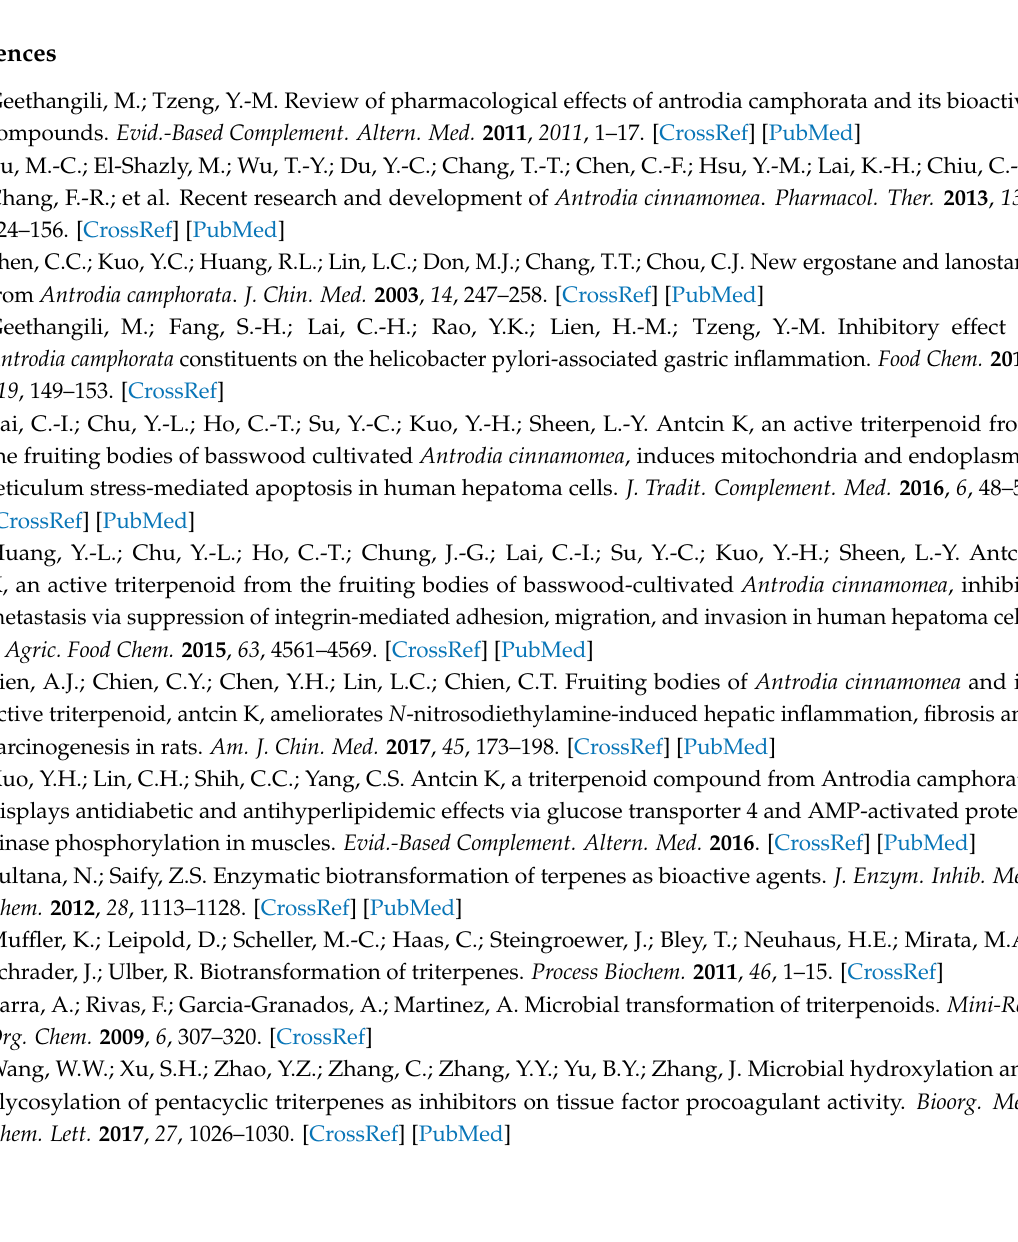
Table S1: NMR spectroscopic data for compound ( 1 ) and compound ( 2 ) (in pyridine- d 5 ; 700 MHz). Figure S1: The UPLC analysis of 24 h fermentation broth of B. subtilis ATCC 6633 in the absence of antcin K. Figure S2: The 1 H-NMR (700 MHz, Pyridine- d 13 C-NMR (176 MHz, Pyridine- d 5 ) spectrum of compound ( 1 ). Figure S3: The 5 ) spectrum of compound ( 1 ). Figure S4: The DEPT-90 and DEPT-135 (176 MHz, Pyridine- d 5 ) spectra of compound ( 1 ). Figure S5: The HSQC (700 MHz, Pyridine- d 5 ) spectrum of compound ( 1 ). Figure S6: The HMBC (700 MHz, Pyridine- d 5 ) spectrum of compound ( 1 ). Figure S7: The H-H COSY (700 MHz, Pyridine- d 5 ) spectrum of compound ( 1 ). Figure S8: The 1 H-NMR (700 MHz, Pyridine- d 5 ) spectrum of compound ( 2 ). Figure S9: The 13 C-NMR (176 MHz, Pyridine- d 5 ) spectrum of compound ( 2 ). Figure S10: The DEPT-90 and DEPT-135 (176 MHz, Pyridine- d 5 ) spectra of compound ( 2 ). Figure S11: The HSQC (700 MHz, Pyridine- d 5 ) spectrum of compound ( 2 ). Figure S12: The HMBC (700 MHz, Pyridine- d 5 ) spectrum of compound ( 2 ). Figure S13: The H-H COSY (700 MHz, Pyridine- d 5 ) spectrum of compound ( 2